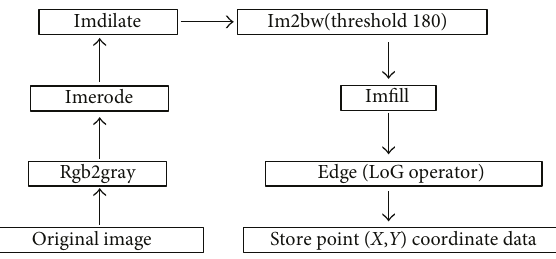
Figure 5: Program fl ow